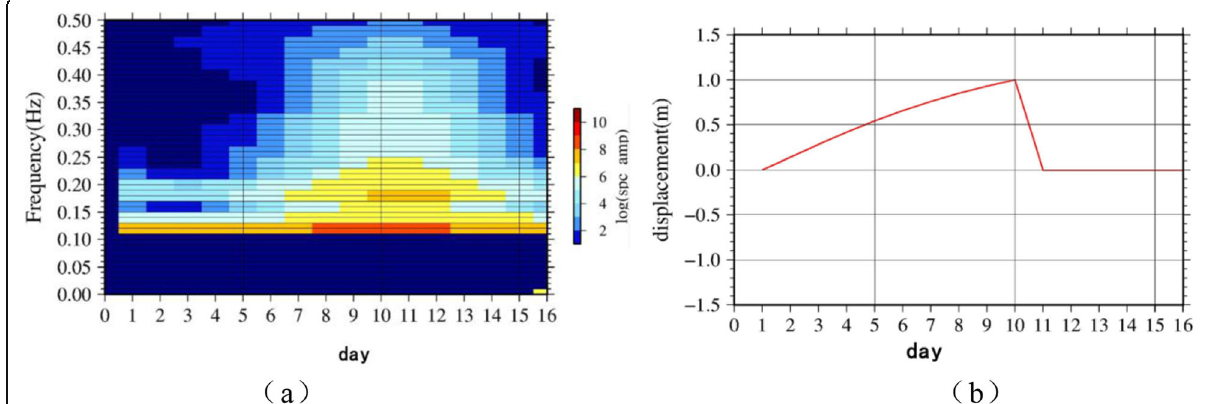
Fig. 13 Ground settlement change of experimental site by wavelet analysis. a Ground settlement wavelet analysis of the experimental site (sampling interval 15 days). Ground settlement sequence map of the experiment site (sampling interval 15